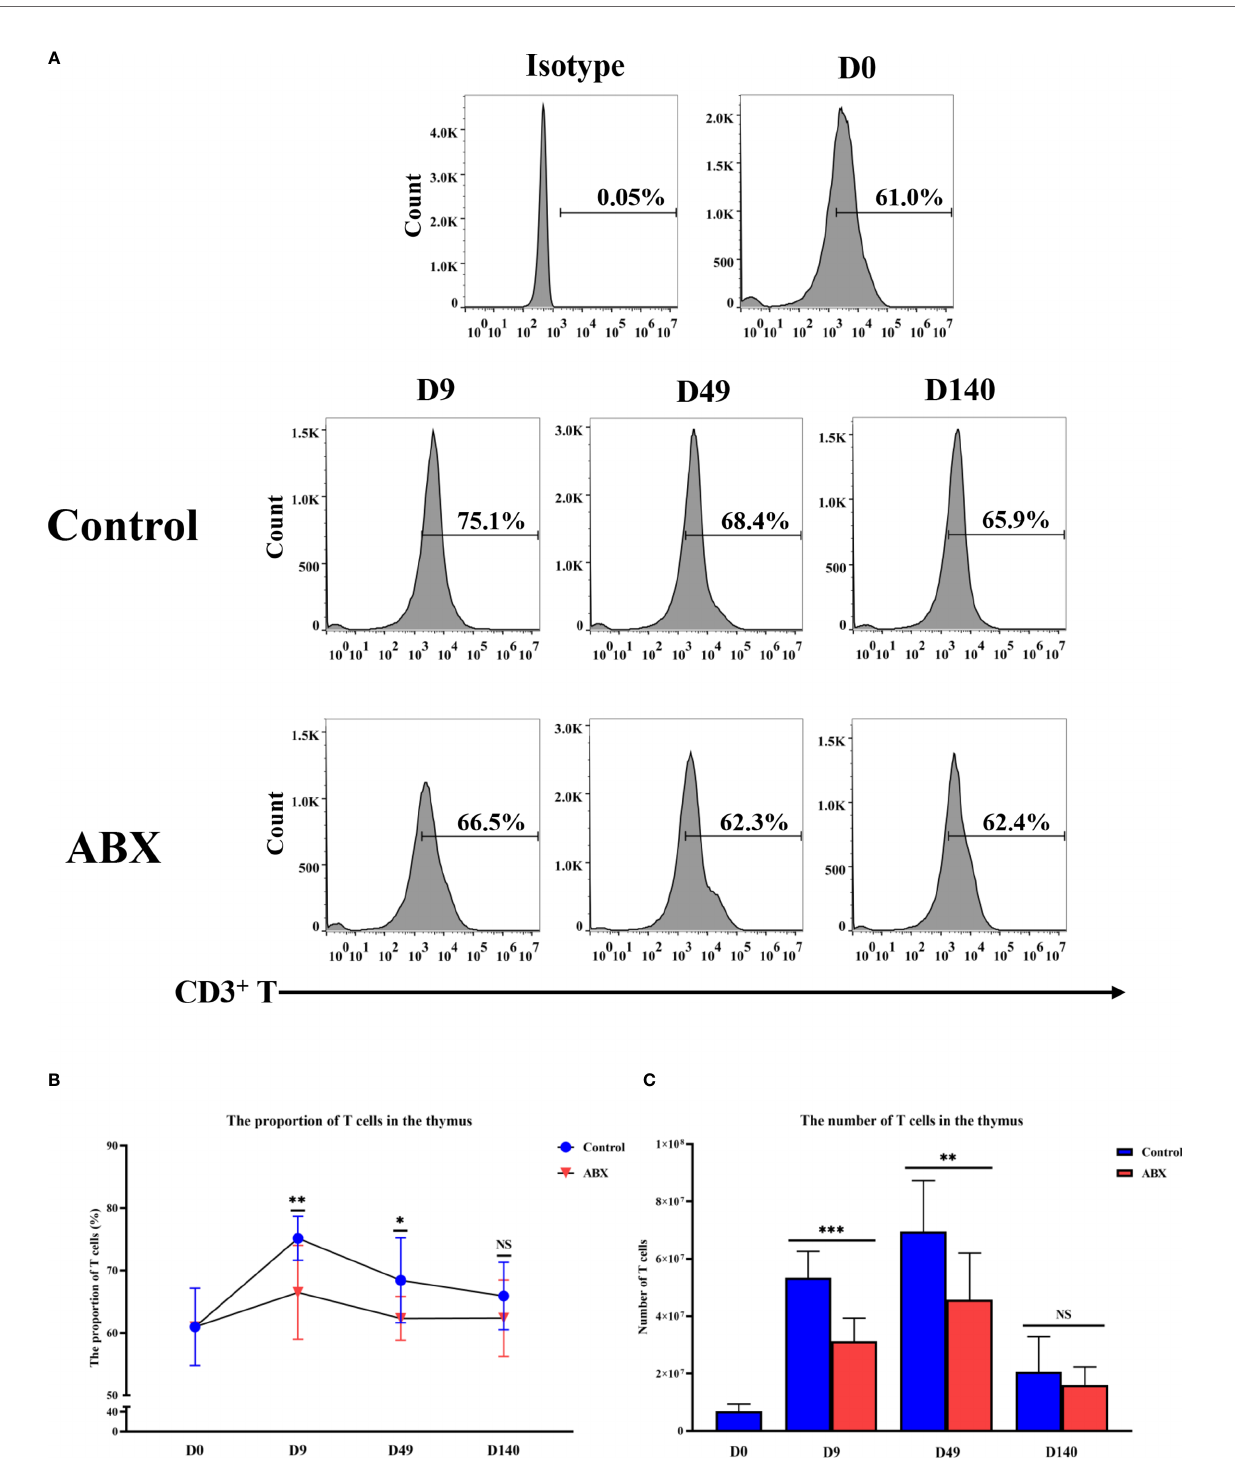
FIGURE 2 | Flow cytometric analysis of T-cell numbers and proportions in thymic tissue. (A) Detection of T-cell content in thymic tissue at different ages by fl ow cytometry. (B) The proportion of T cells in thymic tissue. (C) The number of T cells in thymic tissue. * p < 0.05, ** p < 0.01, *** p < 0.001; unpaired t -test. Ctr, controls; ABX, antibiotic-treated chickens. n ≥ 12 for each group. ns, not signi fi